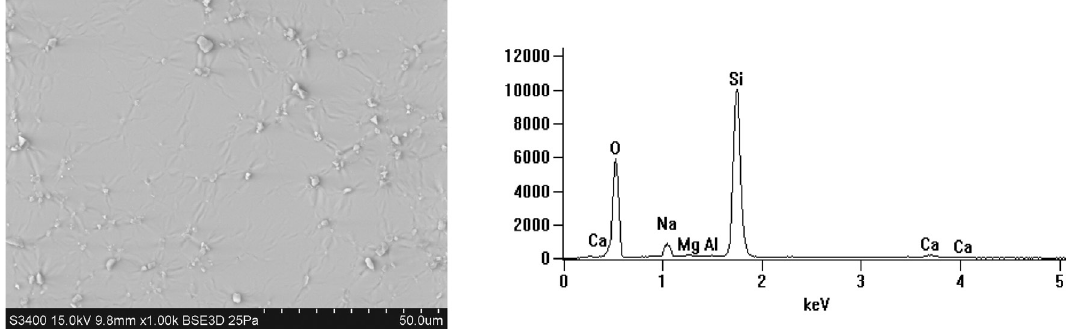
Fig. 4: Results of microstructure and EDS/SEM analysis of glass refined using silicon oxide (TK)